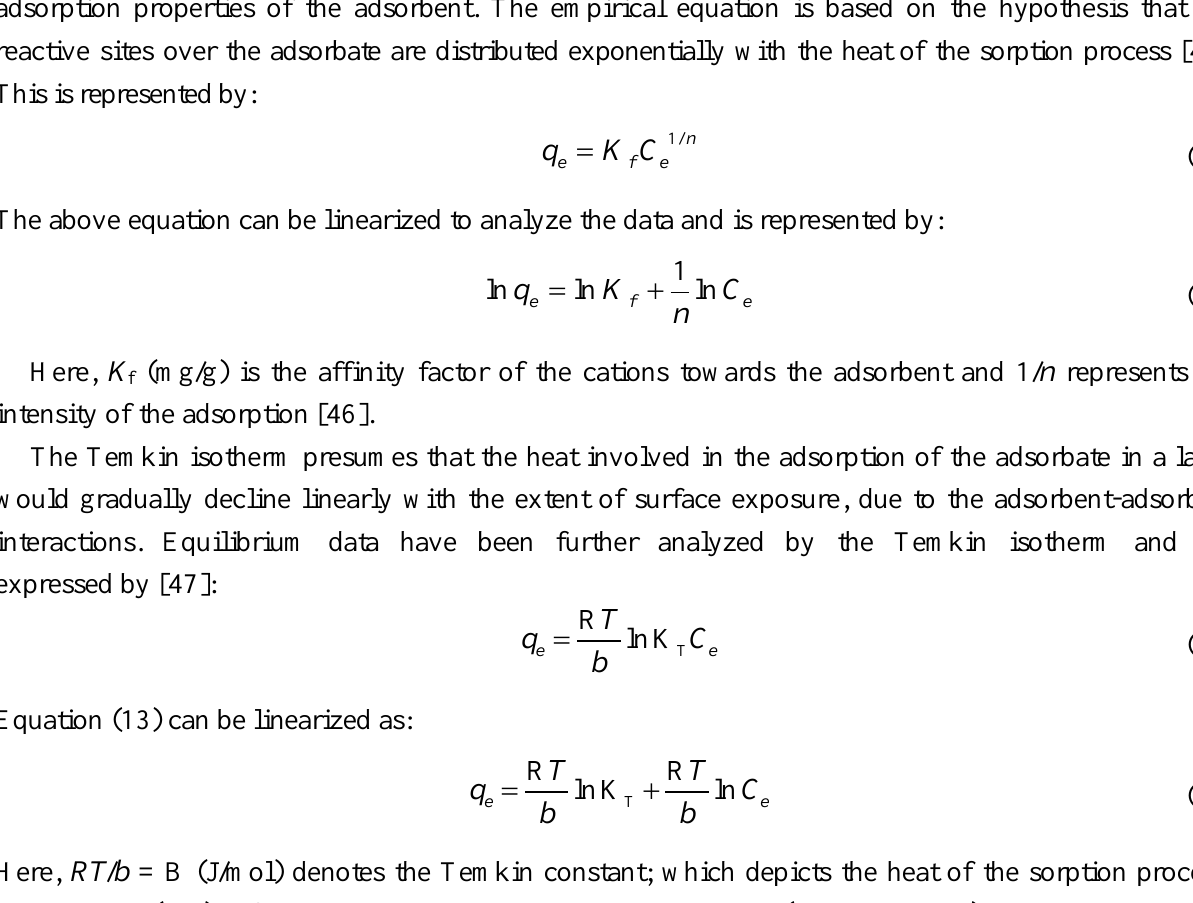
Table 6. Types of isotherm based on separation factor R